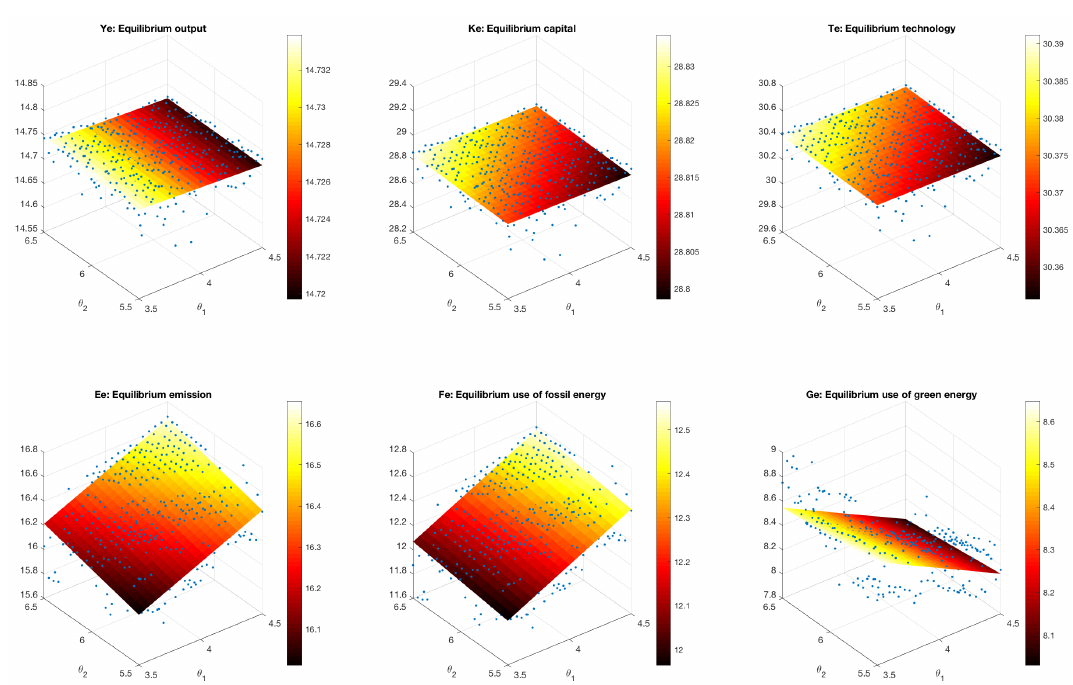
Figure A2. Equilibrium values on grid, OECD countries: fitted